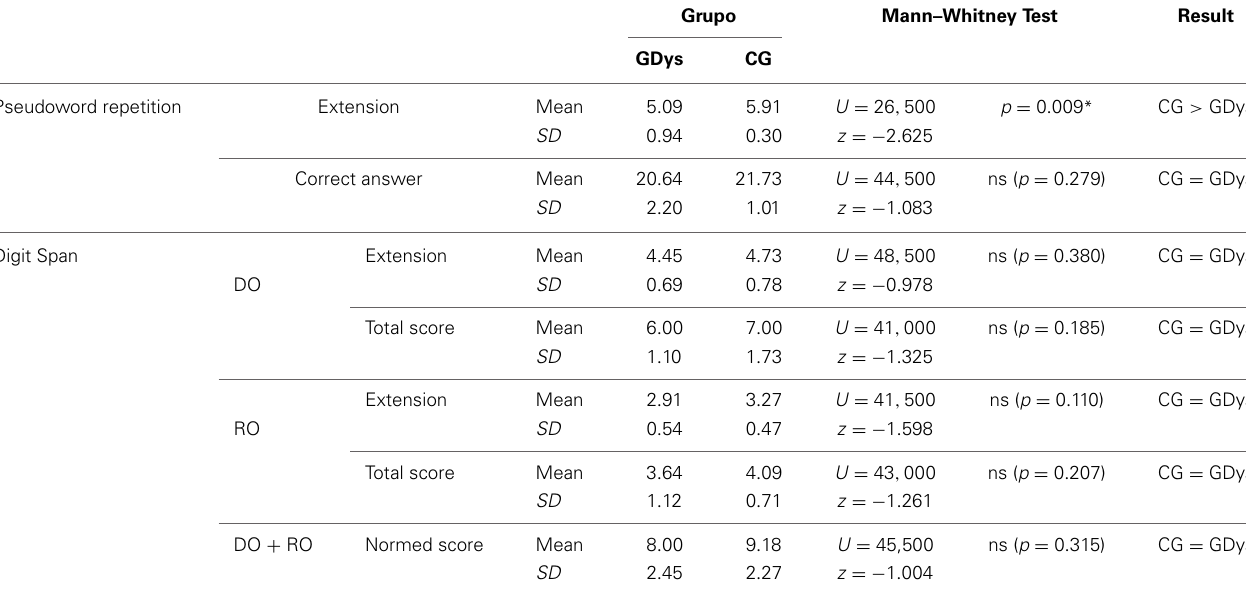
Table 3 | Comparison of performances obtained in the test of Digit Span and Pseudoword